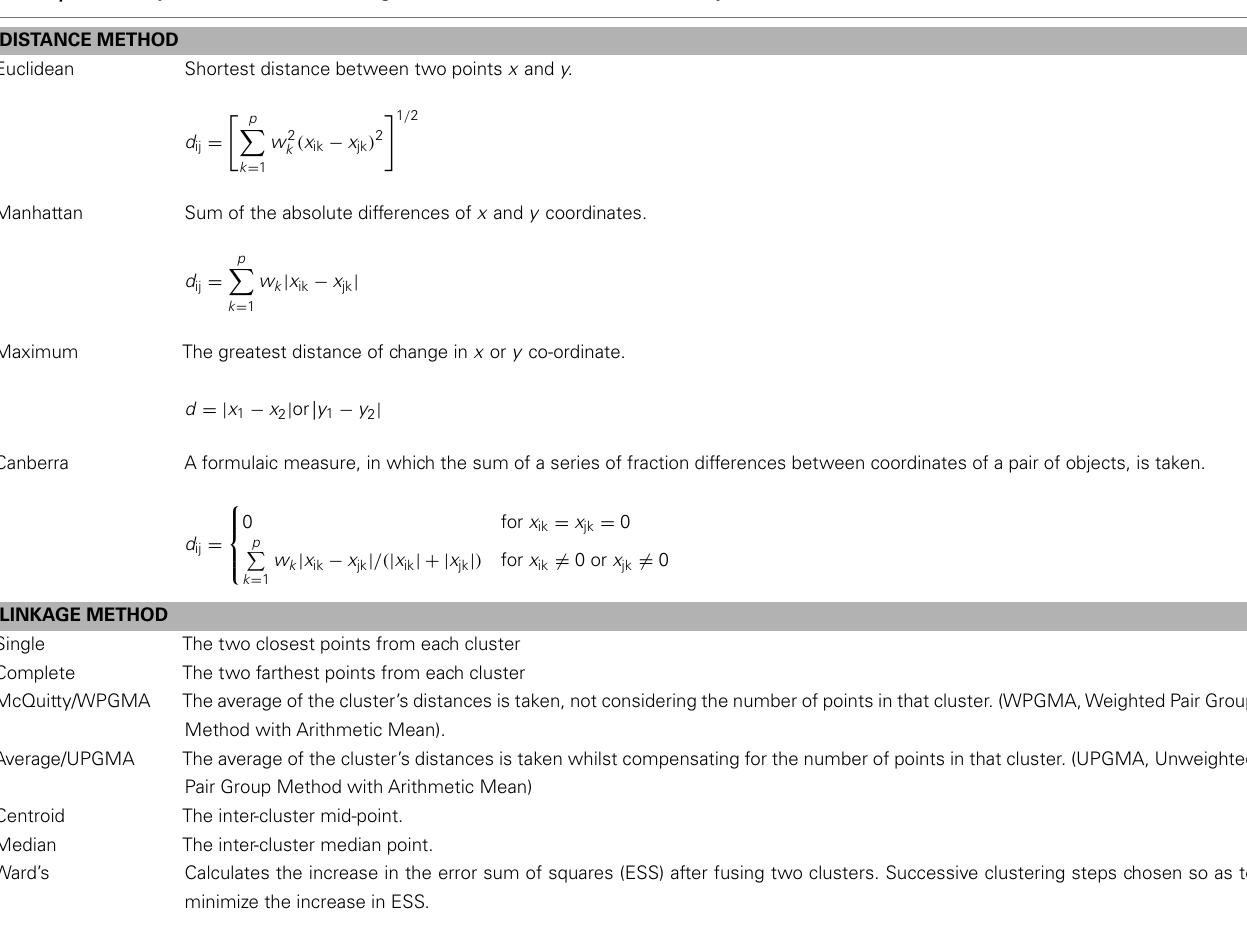
Table 1 | Commonly used distance and linkage methods to determine from which point in each cluster the inter-cluster distance is